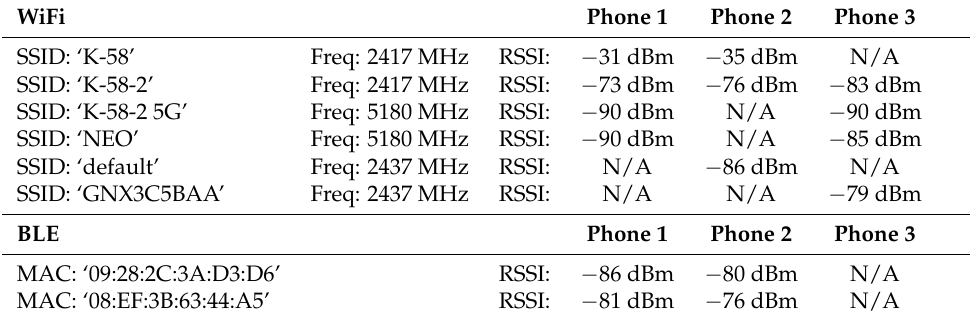
Table 1. An example of three indoor measurements (home